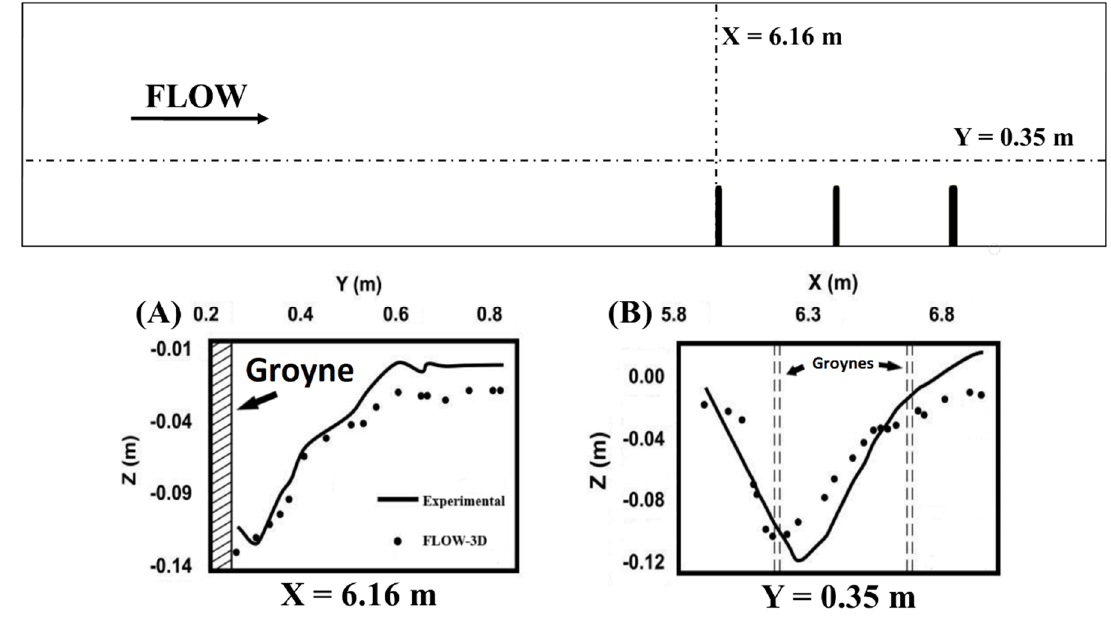
Figure 7. Experiment and FLOW-3D scour profiles, ( A ) cross section at x=6.16m, ( B ) longitudinal section at y=0.35m.